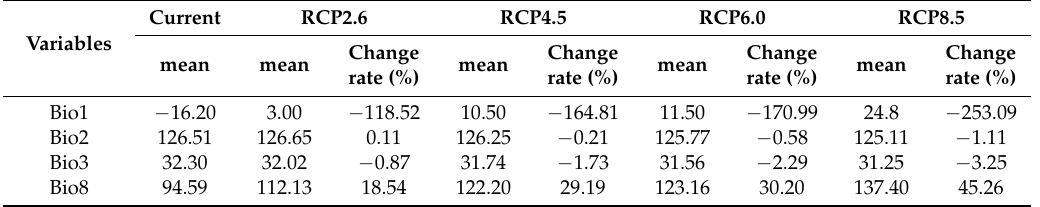
Table 2. Climatic variables selected in this study and their percent contribution to each scenario. Variables